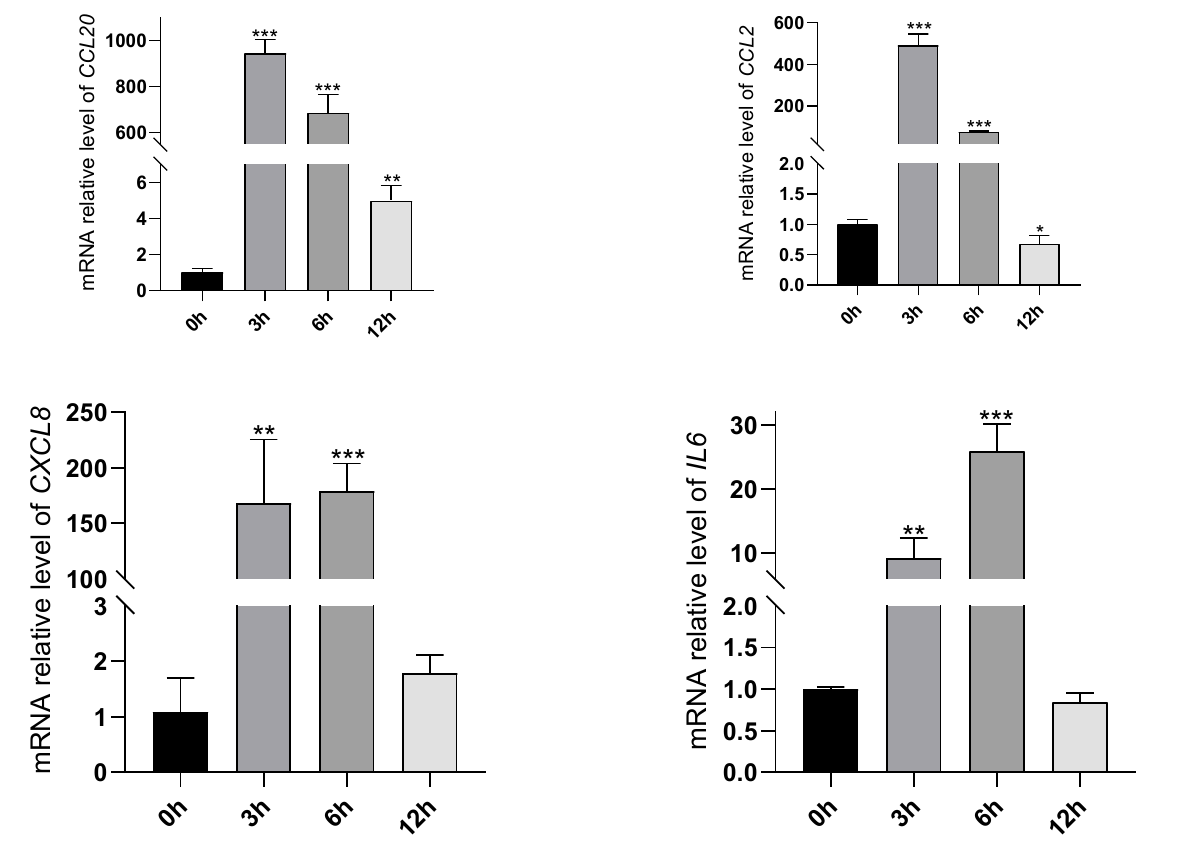
Figure 6. RT-qPCR analysis for CCL2 , CCL20 , CXCL8 and IL6 genes. ( n = 3, * p < 0.05, ** p < 0.01, *** p < 0.001, compared with blank control group).